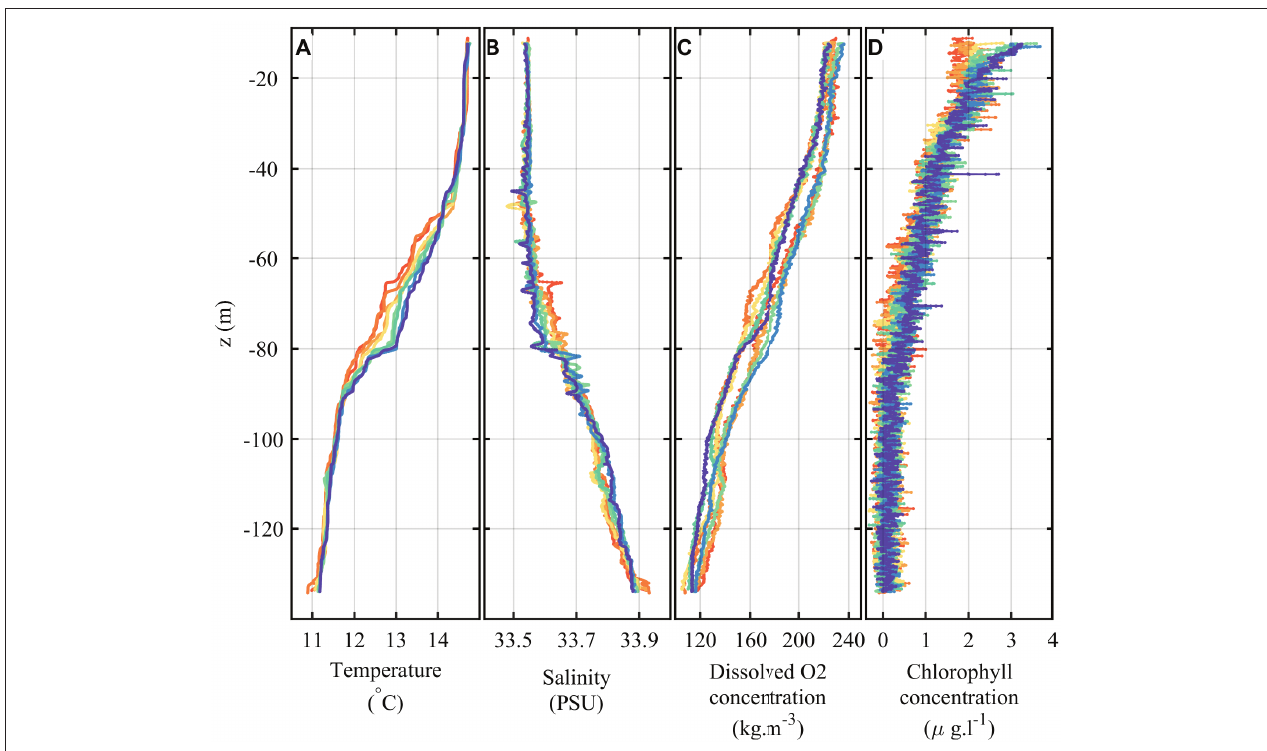
FIGURE 15 | Depth profiles of water properties measured by the RBR Concerto 3 CTD mounted on the sinker of the subsea winch of the SV3 Wave Glider Planck . (A) Temperature. (B) Salinity. (C) Dissolved O 2 concentration. (D) Chlorophyll concentration. Eight consecutive profiles are shown over the course of 96 min. These data were measured during a test deployment off the SIO pier on 7 February 2020. Data are smoothed by averaging the data over a 1 s sliding